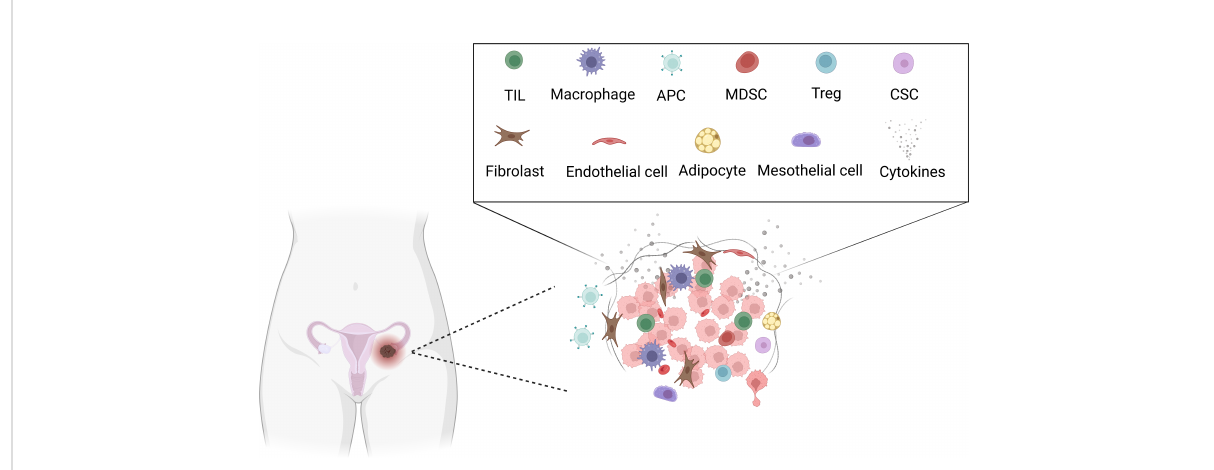
FIGURE 2 Tumor microenvironment in ovarian cancer. Created with BioRender.com. TIL: Tumor-in fi ltrating lymphocytes (TILs), APC: Antigen-presenting cell, MDSC: Myeloid-derived suppressor cells (MDSCs), Treg: Regulatory T, CSC: cancer stem